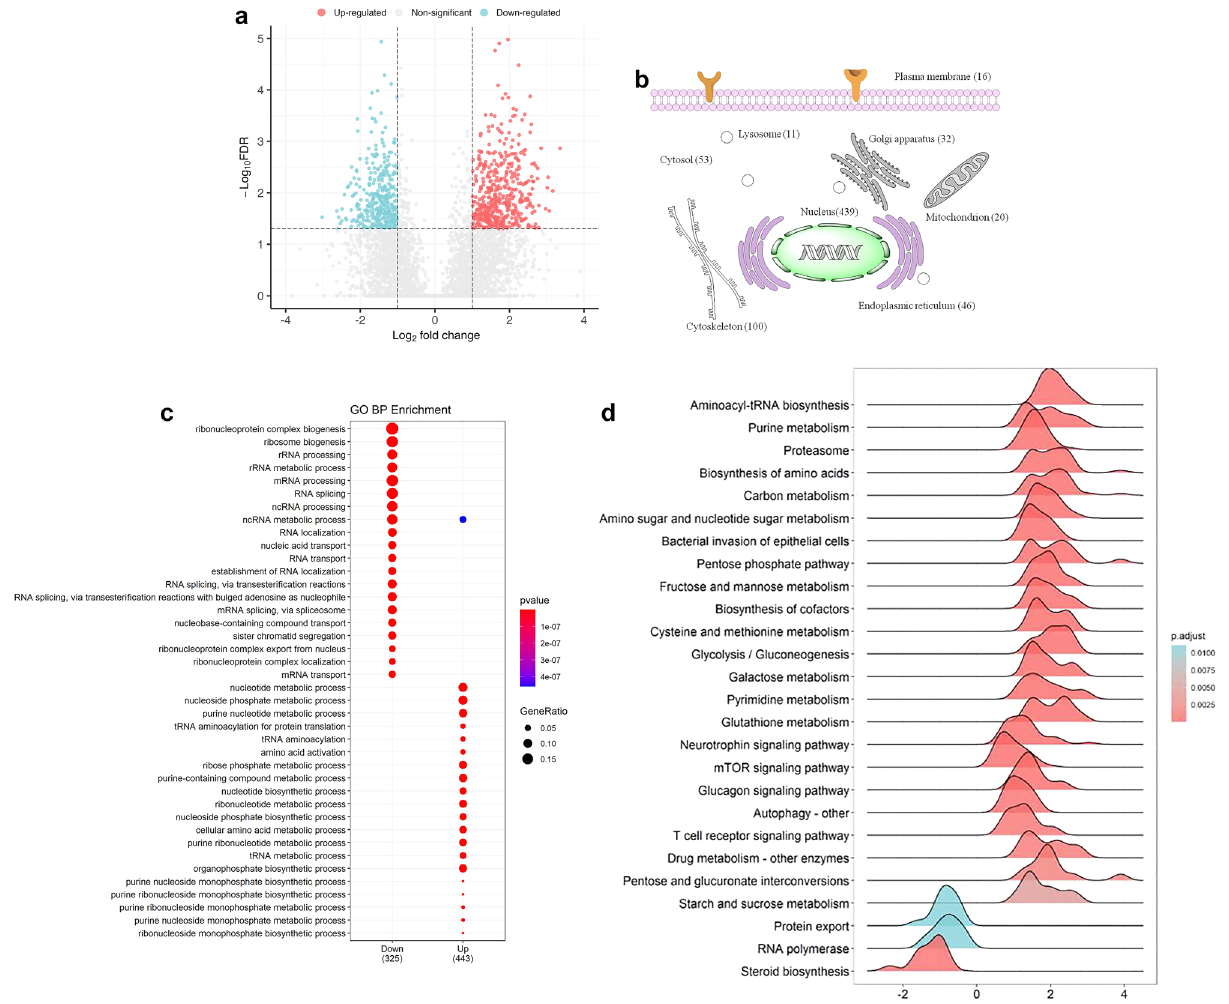
Figure 2. Proteome profiling of B. pseudomallei HNBP001 infected RAW264.7 cells. ( A ) Volcano plot of 811 differential expressed proteins. The Log2-transformed fold change and − log 10-transformed adjusted P -value were denoted by the x-axis and y-axis, respectively. ( B ) Subcellular distribution of proteins was annotated with Gene Ontology. Many proteins were annotated as the intracellular matrix, and 50% of proteins were located in the nucleus. ( C ) The Biological Processes altered in the Bp group compared with the NC group. The top 20 significantly altered terms of up-regulated and down-regulated proteins were depicted in the picture. ( D ) The ridgeline plot for expression distribution of core-enriched proteins in KEGG categories, where the x-axis represented Log2-transformed fold